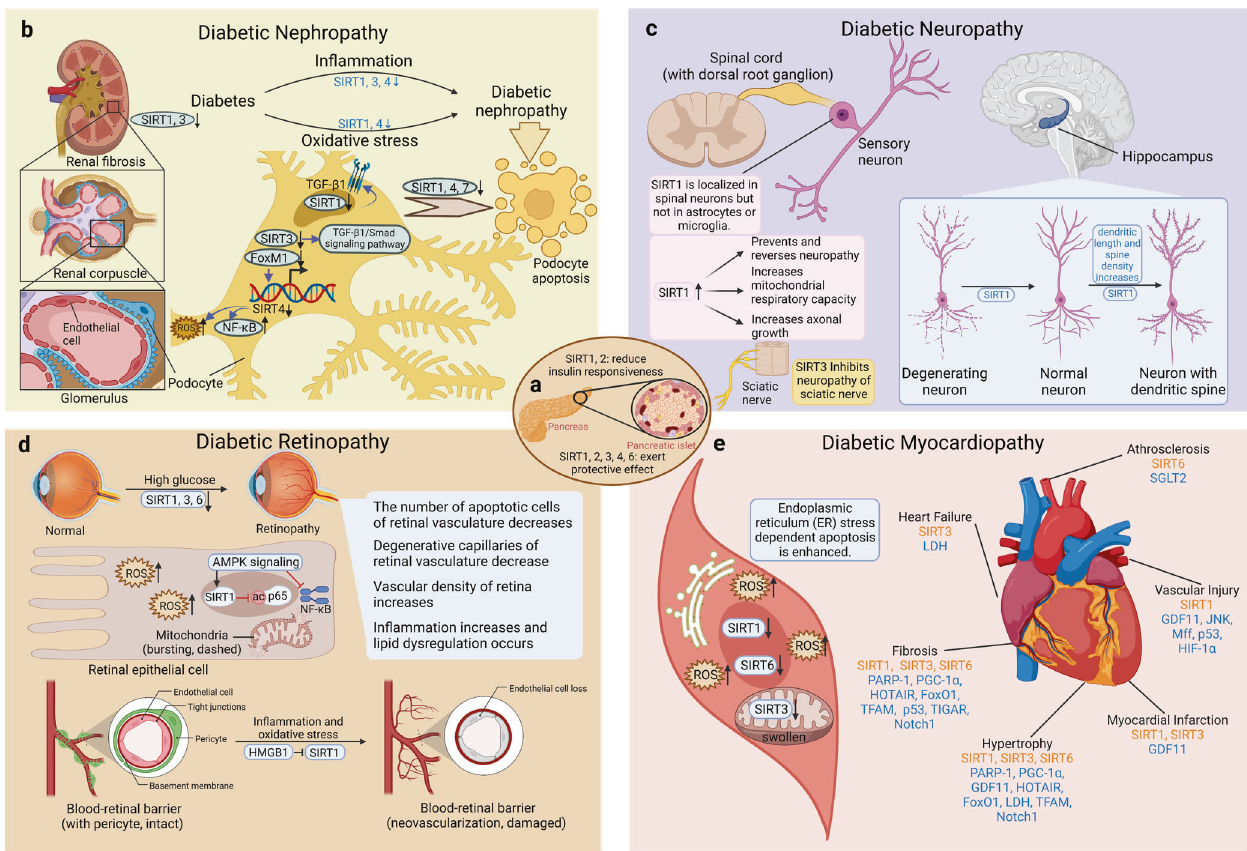
Fig. 14 The roles of SIRTs in diabetes and related target organs injury. a SIRT1, SIRT2, SIRT3, SIRT4, and SIRT6 are associated with pathological processes in the occurrence and development of DM. SIRT1 and SIRT2 have dual functions, including both improving insulin sensitivity and reducing insulin responsiveness. SIRT3, SIRT4, and SIRT6 mainly exert protective effect on DM. b SIRT1, SIRT3, SIRT4, and SIRT7 play protective roles in diabetic nephropathy. Low levels of SIRT1 and SIRT3 are associated with renal fi brosis and reduced expressions of SIRT1, SIRT4, and SIRT7 are related to podocyte apoptosis. c Increasing SIRT1 expression can exert protective effect during the development of neuropathy in sensory neuron of spinal cord. Moreover, SIRT1 could also reverse neuron damage in hippocampus. In addition, SIRT3 may inhibit